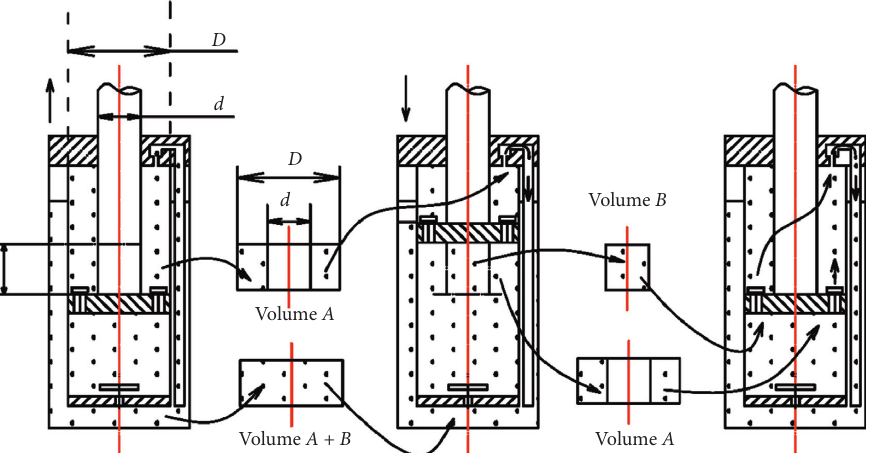
Figure 3: Working principle of the yaw damper.